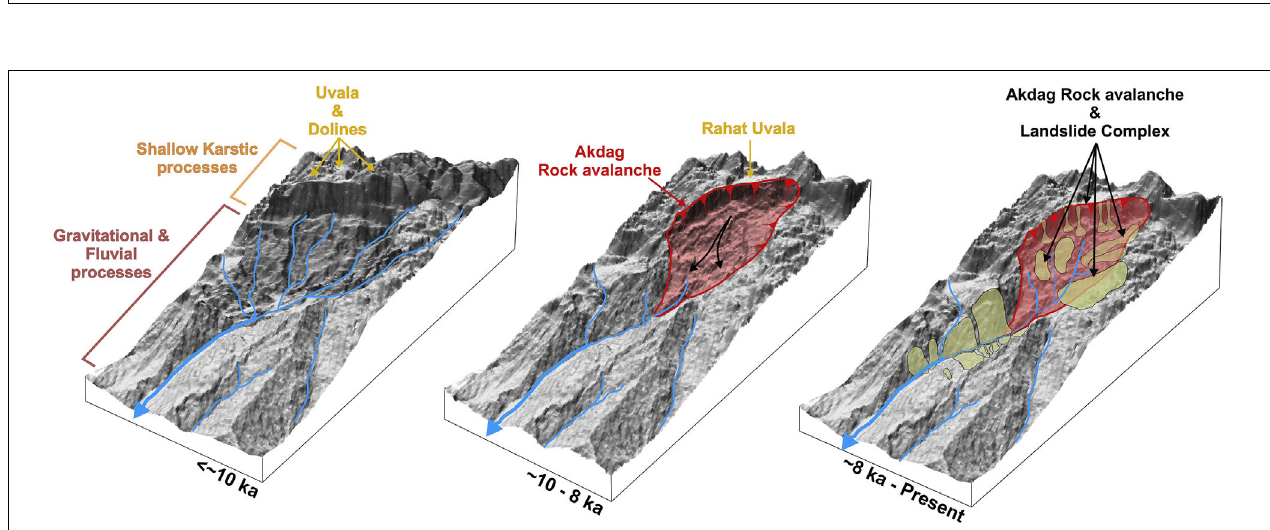
FIGURE 15 | Schematic three-dimensional diagram showing the eventual morphologic appearance before and after Akdag rock avalanche. Blue lines and arrows denote river network and flow direction, respectively.